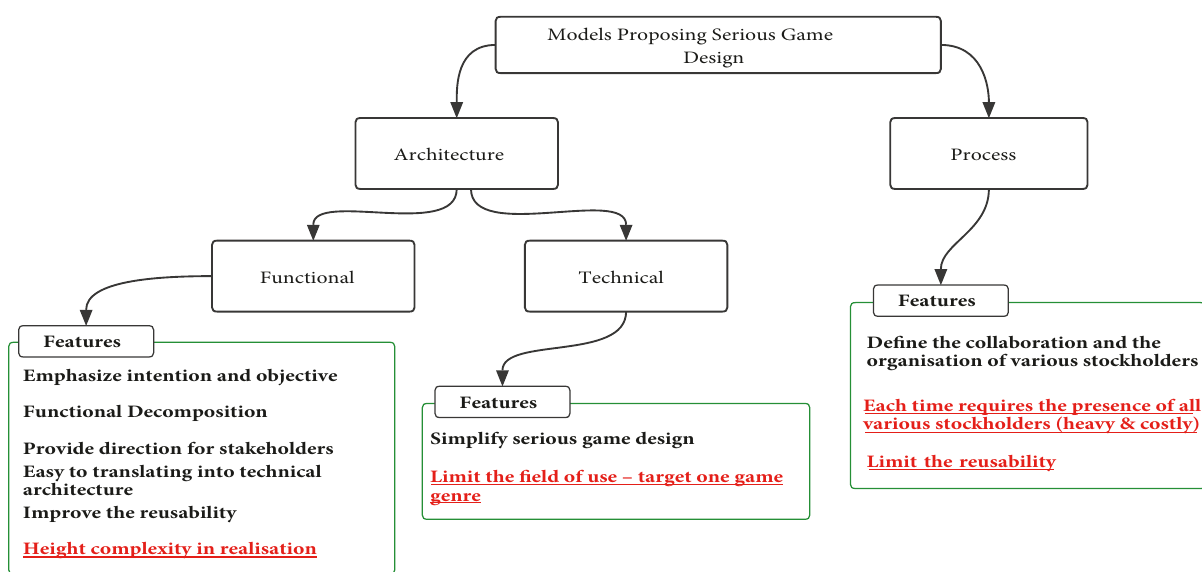
Figure 3: The hierarchical classification of models approaching SG